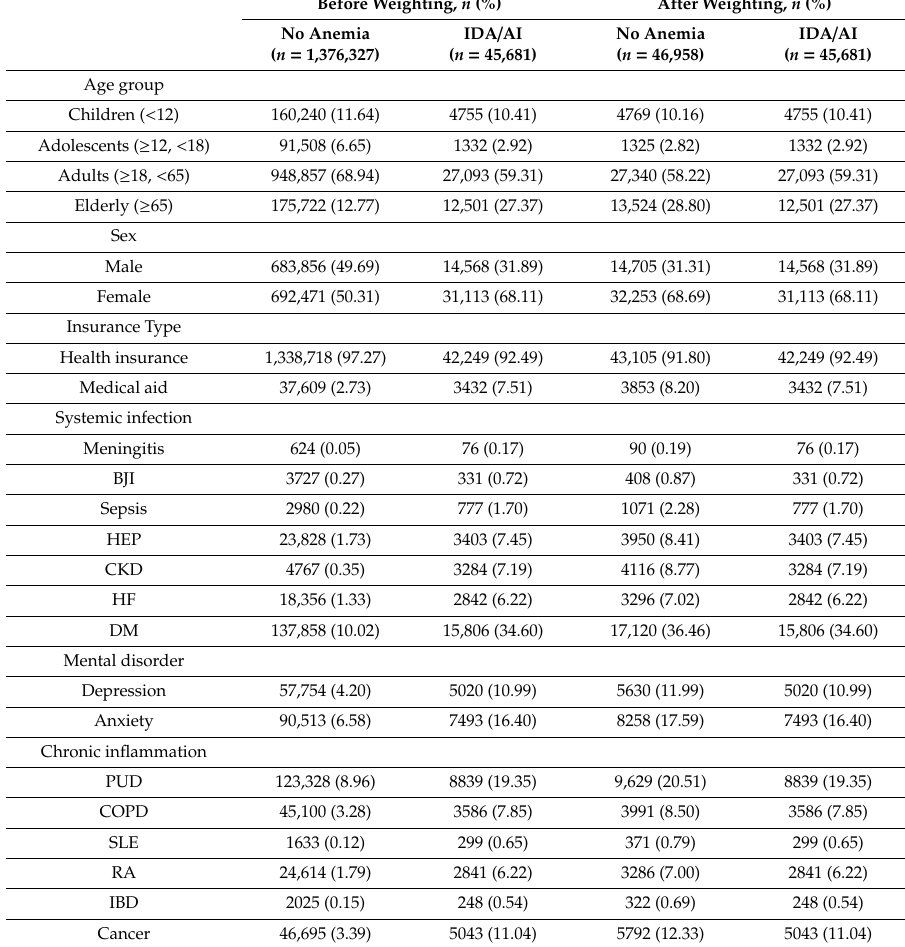
Table 1. Baseline characteristics of subjects before and after inverse probability of treatment weighting. Before Weighting, n